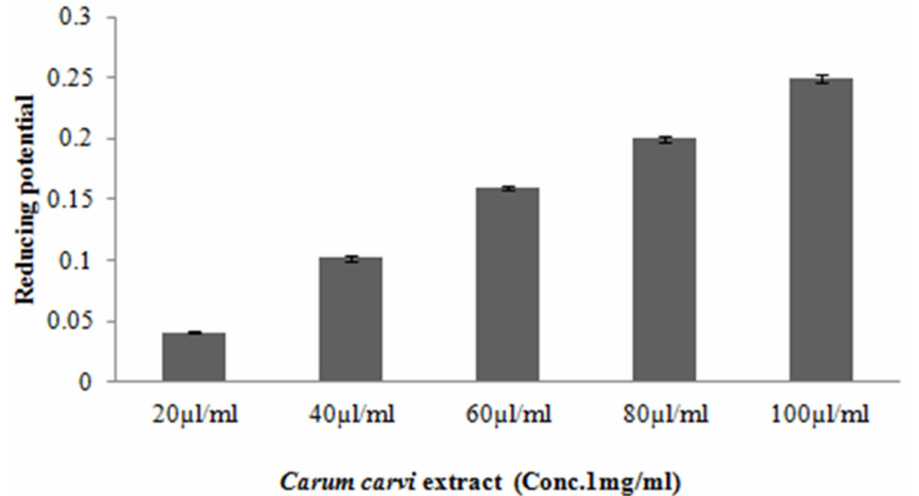
Figure 3. Ferric reducing antioxidant potential of Carum carvi. Representative graph showing concentration-dependent ferric reducing potential of Carum carvi. All samples were analyzed in trip-